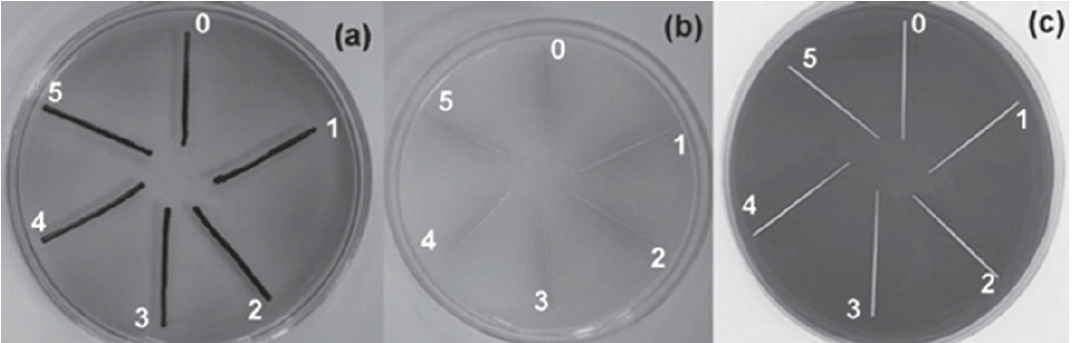
Fig. 2 . Positive control showing: (A) S. aureus growth; (B) P. aeruginosa growth. Negative control showing: (C) no microbial growth.